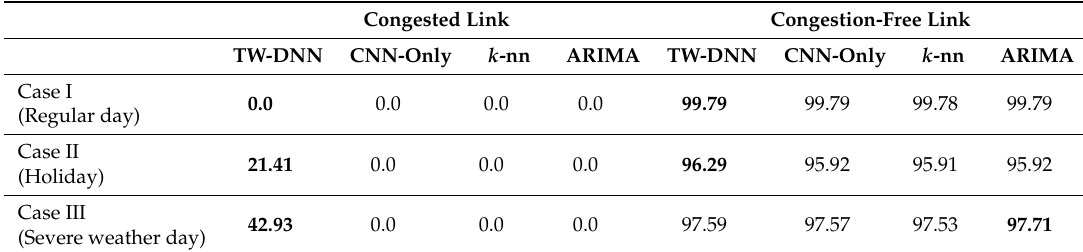
Figure 13. Speed figure of ( a ) real data, ( b ) TW-DNN, ( c ) CNN-only, ( d ) k -nn, and ( e ) ARIMA for Case III. Table 3. Accuracy of predicting congestion for the test